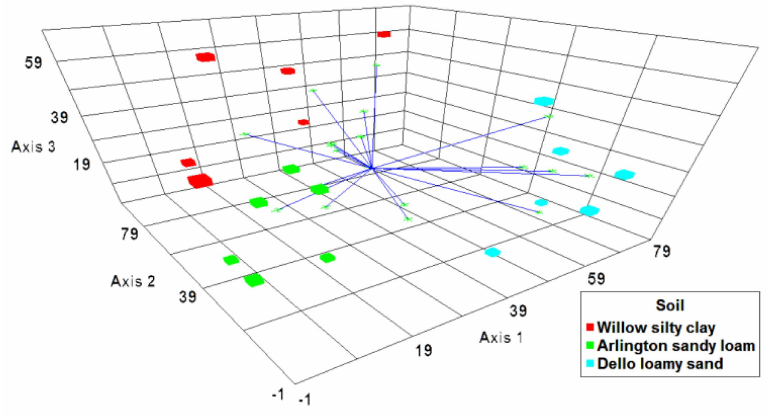
Figure 6. Analysis the similarity of fungi communities in different cucumber rhizosphere soils based on NMDS analysis of DGGE bands of the 18 soil